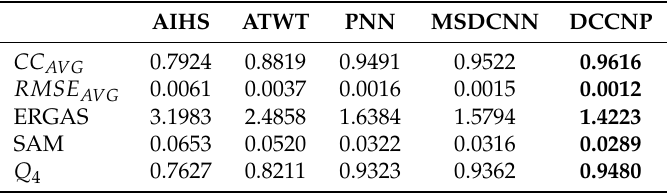
Table 2. Quantitative assessments of IKONOS data. ERGAS, erreur relative global adimensionnelle de synth` e se; SAM, spectral angle